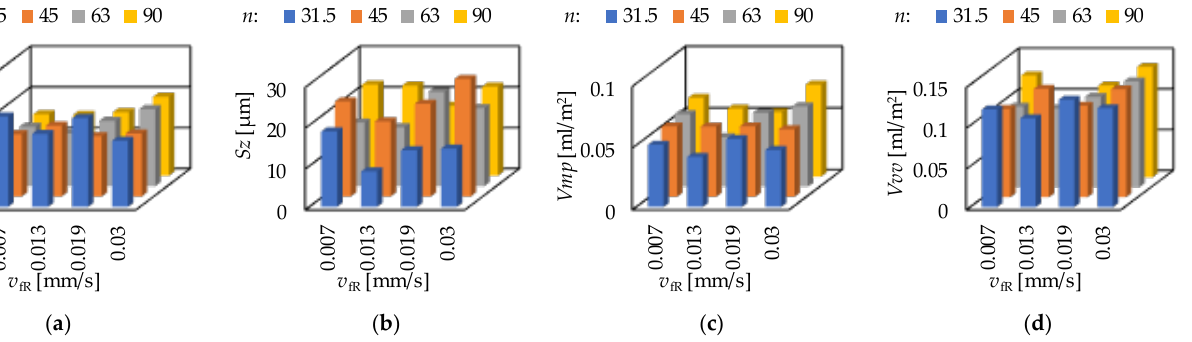
Figure 10. The measured kurtosis ( Sku ) values for hard turning by applying ( a ) f = 0.05 mm/rev, ( b ) f = 0.1 mm = rev, ( c ) f = 0.15 mm/rev, ( d ) f = 0.2 mm/rev. The ground surfaces were machined by infeed grinding. The two influencing cutting data were the infeed velocity ( v fR ) and the rpm of the workpiece ( n ). The results are demonstrated in Figures 11 and 12. It can be observed that there is no clear relationship between the cutting data and the topography parameters.